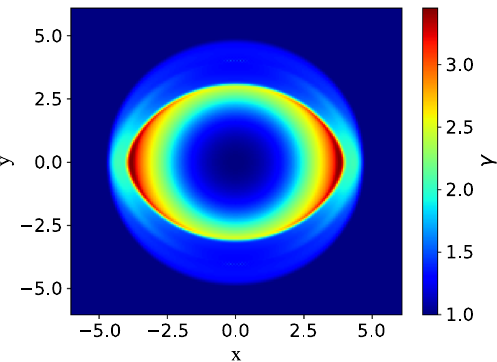
Fig. 8 The Lorentz factor γ at t = 4 is shown in the 2D cylindrical explosion problem